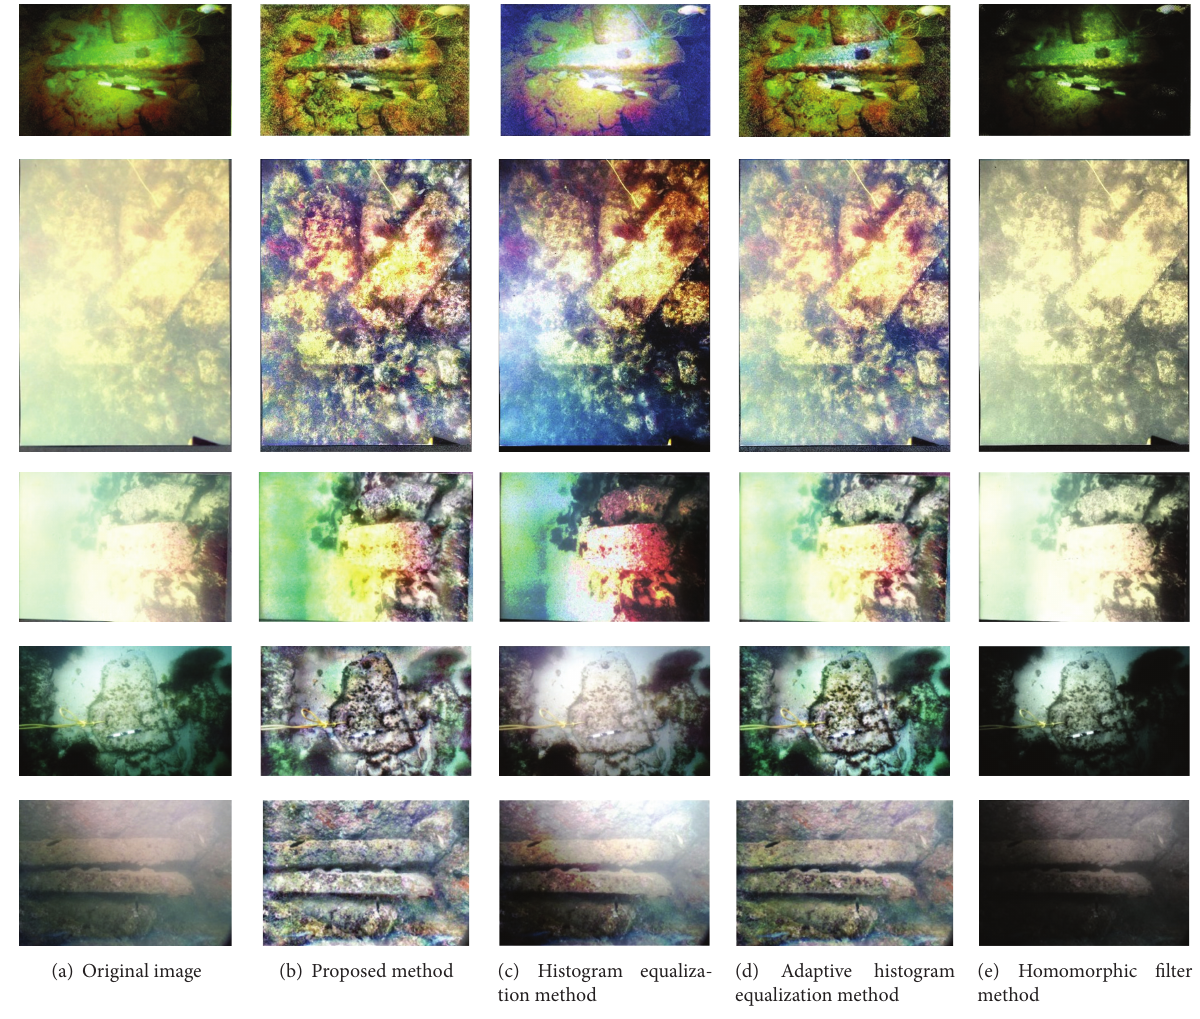
Figure 4: Results of all four